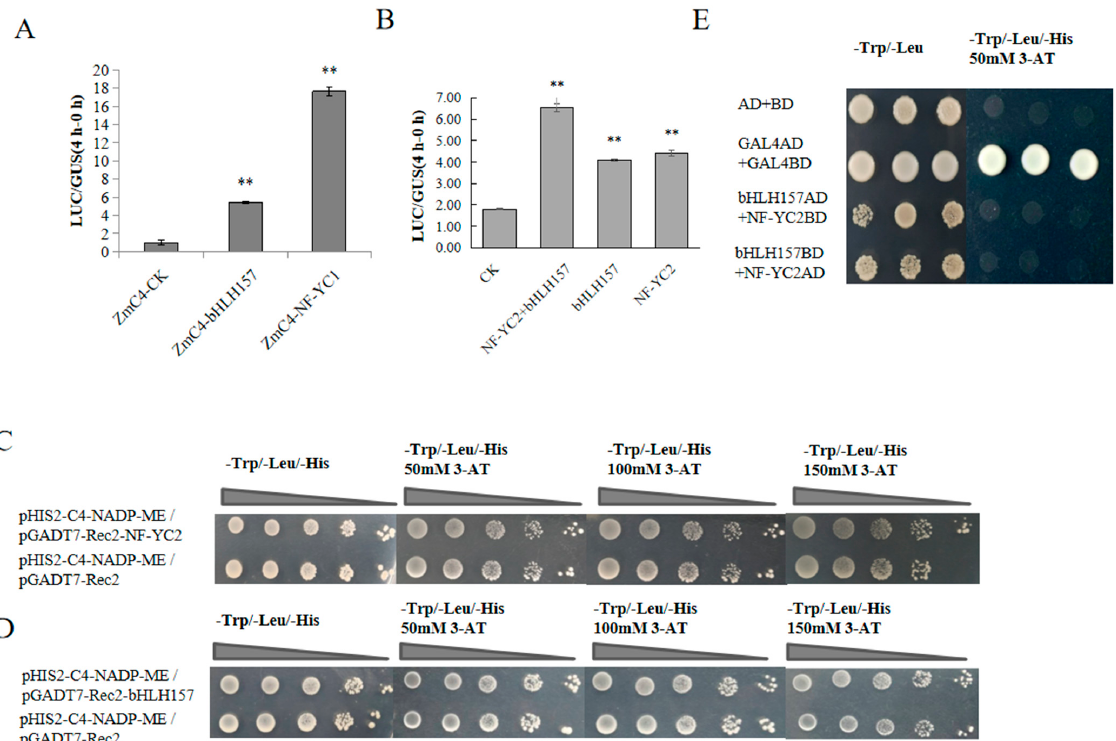
Figure 3. Interaction analysis of bHLH157, NF-YC2 and ZmC4 NADP-ME promoter. ( A ) Interaction with promoter individually in protoplasts. ( B ) Synergistical interaction with promoter. ( C ) The interaction analysis of NF-YC2 and the promoter in yeast, pGADT7-Rec2, was the negative control. ( D ) The interaction analysis of bHLH157 and promoter in yeast. ( E ) Two-hybrid in yeast, “AD + BD“ was the negative control and “GAL4AD + GALBD” was the positive control. “**” represented as p < 0.01.